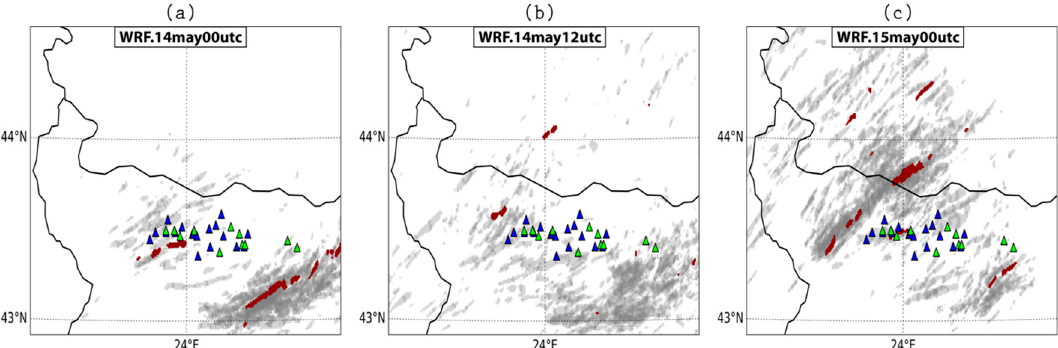
Figure 15. Forecast performance overview for ( a ) WRF.14may00utc, ( b ) WRF.14may12utc and ( c ) WRF.15may00utc. The gray (maroon) scatter dots show locations where the 50 ensemble members (the control forecast) contained hourly-maximum 2–5 km UH values in excess of 180 m 2 s − 2 for the time period between 10:00 UTC and 14:30 UTC. The forecasted UH swaths were compared to hail reports from National Institute of Meteorology and Hydrology (NIMH) (blue) and European Severe Weather Database (ESWD) (green) on 15 May 2018.